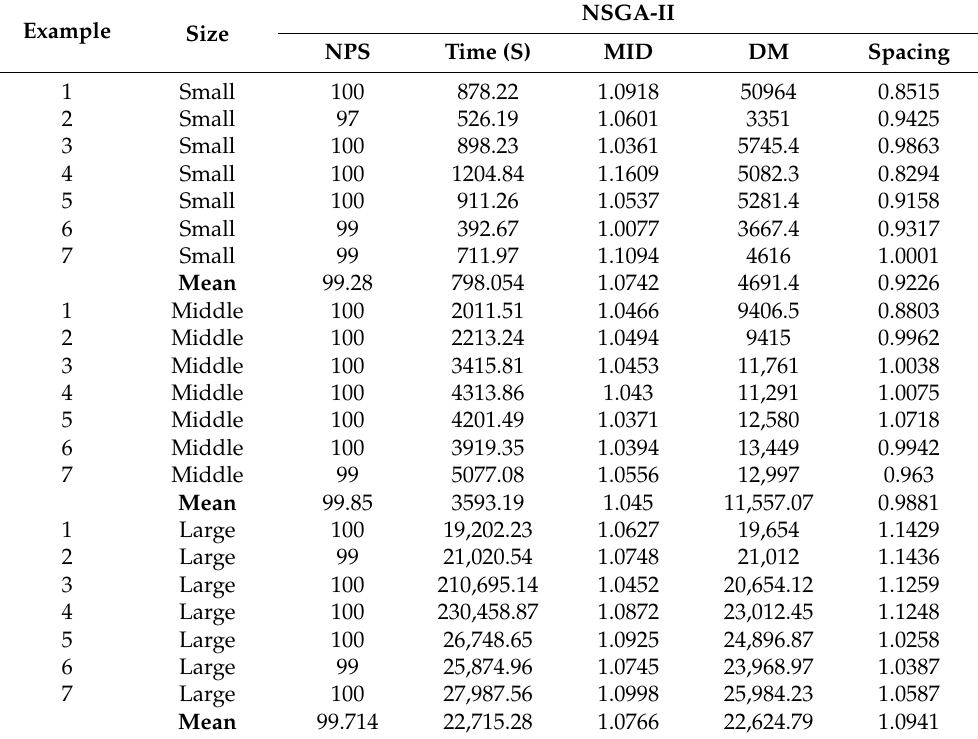
Table 19. Criteria values of the NSGA-II algorithm.